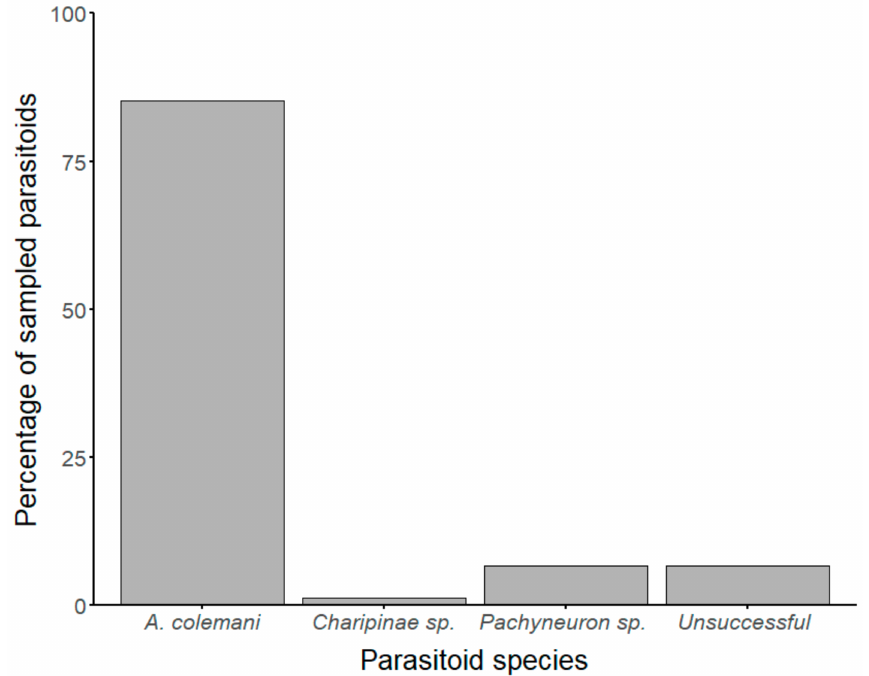
Figure 2. Parasitoid and hyperparasitoid species from the host Aphis fabae (Hemiptera: Aphididae) identified by sequencing ‘mini-barcodes’. The primary parasitoids were A. colemani (Hymenoptera: Braconidae: